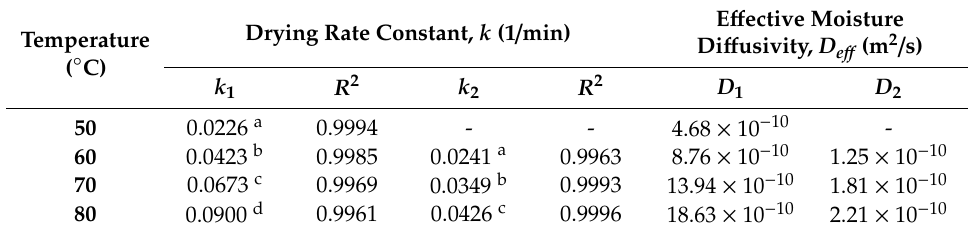
dried in a fluidized bed dryer at a constant velocity of 2.87 m / s.